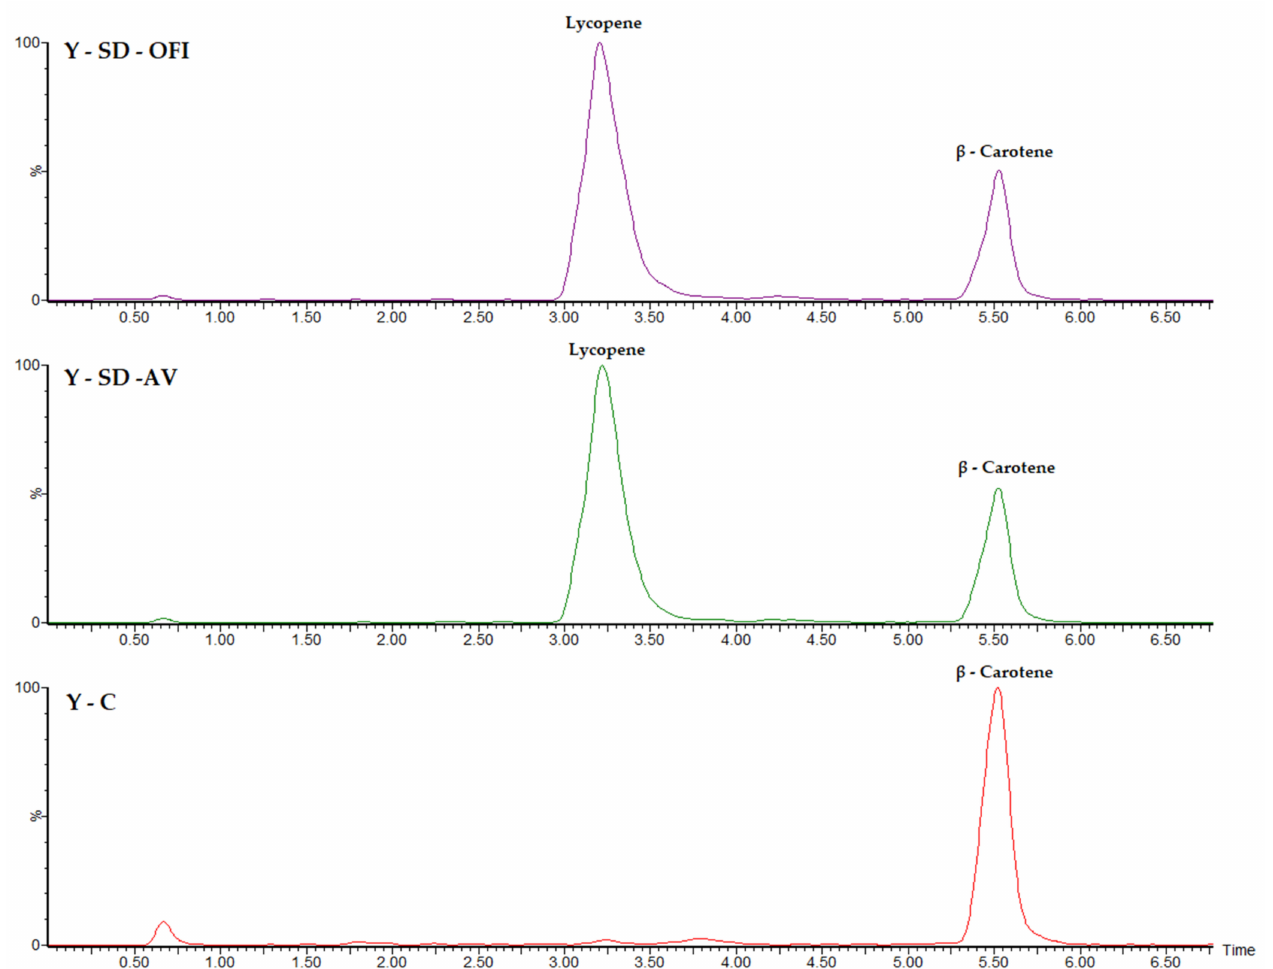
Figure 3. HPLC–MS chromatograms of the Y-SD-OFI, Y-SD-AV, and Y-C yogurt